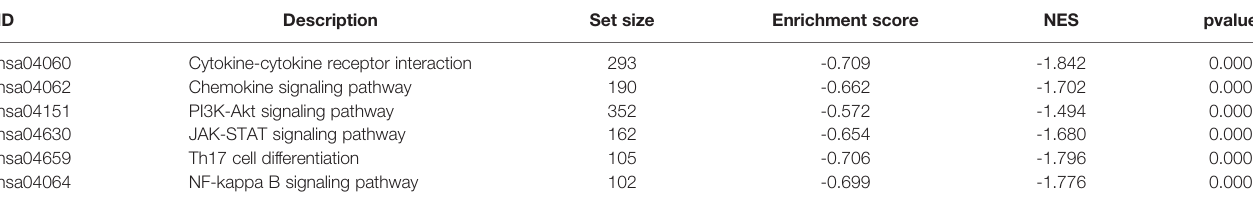
TABLE 1 | The enriched KEGG pathways associated with the